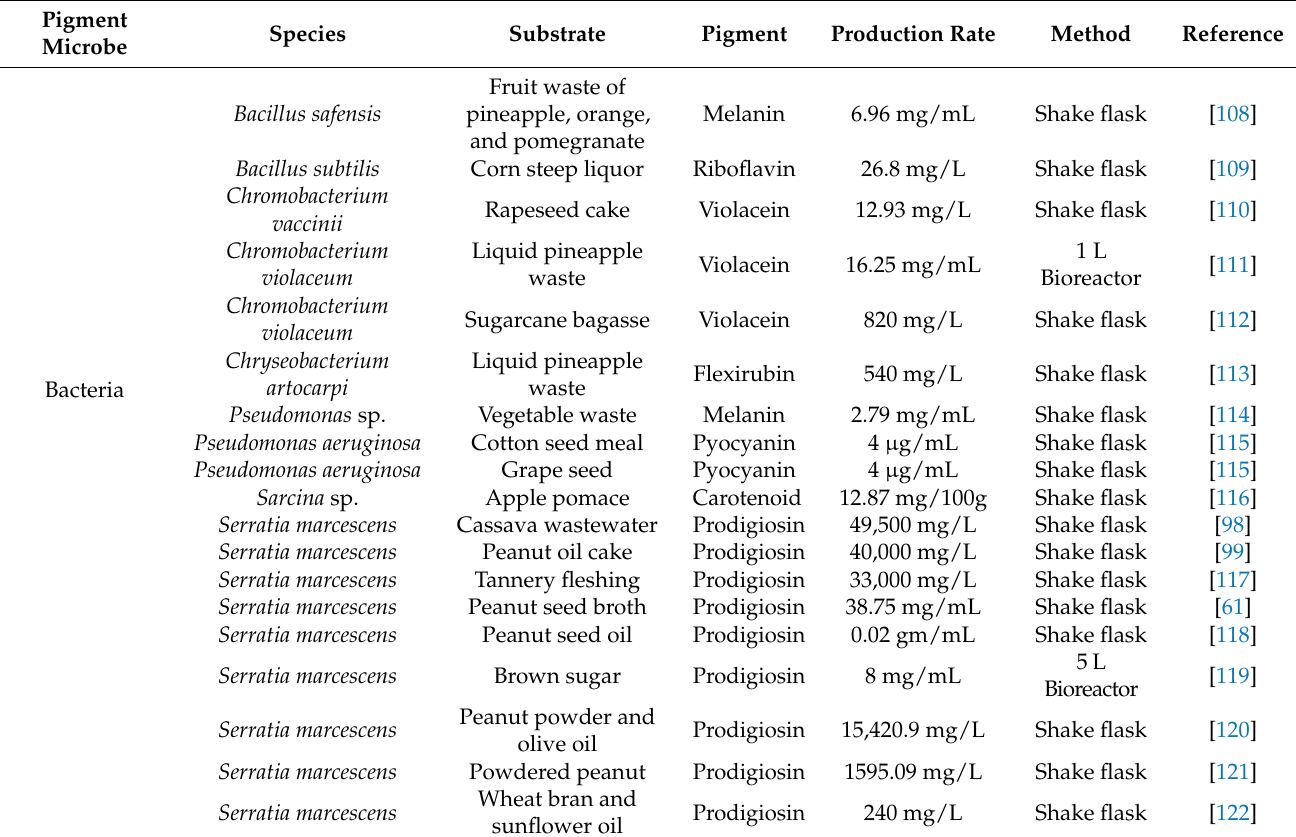
Table 2. Various substrates stimulating high pigment content from industrially important microbes. Readers may refer to the corresponding references for more details about the substrate concentration and media